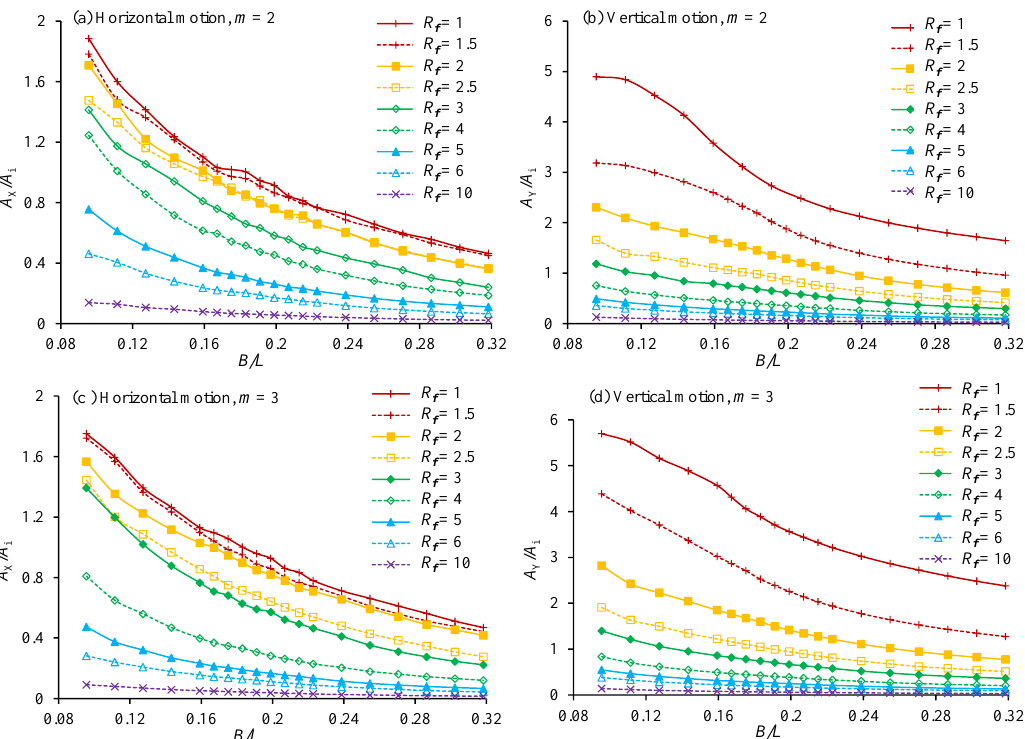
Figure 6. Variation of the amplitude of the oscillatory horizontal and vertical motion of the floating OWC chamber for K t = 3000 Pa·m −3 ·s and d/h = 0.25.